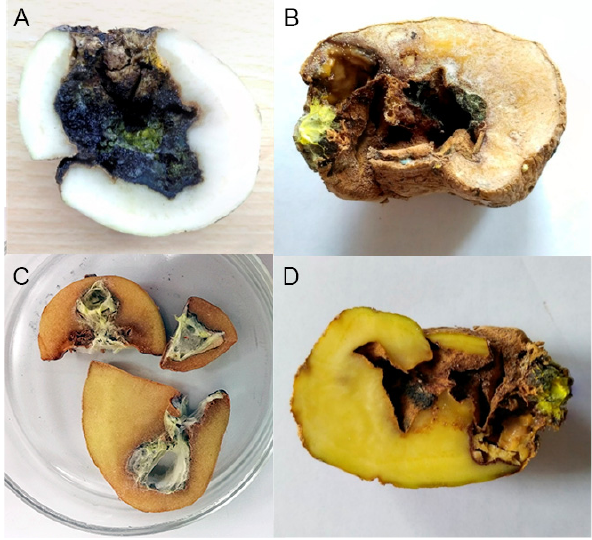
Figure 6. Source potato tubers, infected by yellow rot. ( A ) VKM F-4914, ( B ) VKM F-4913, ( C ) VKM F-4915, ( D ) VKM F-4902.